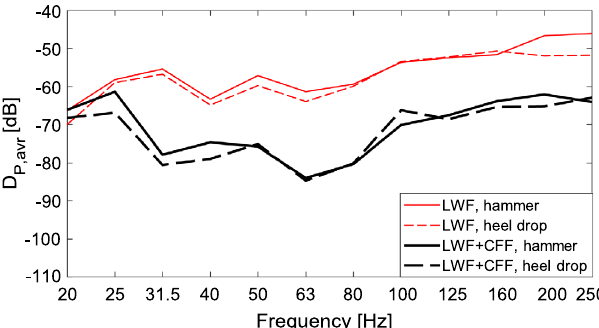
Figure 17. One-third-octave-band level of the impact sound normalized by force. The impact and receiver positions are shown in Figure